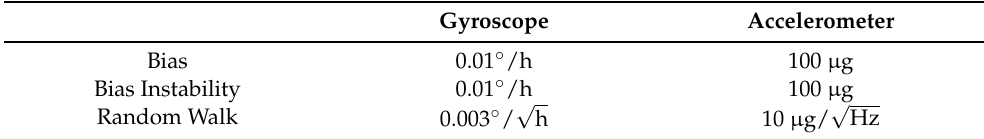
Table 1. The parameters of the INS.